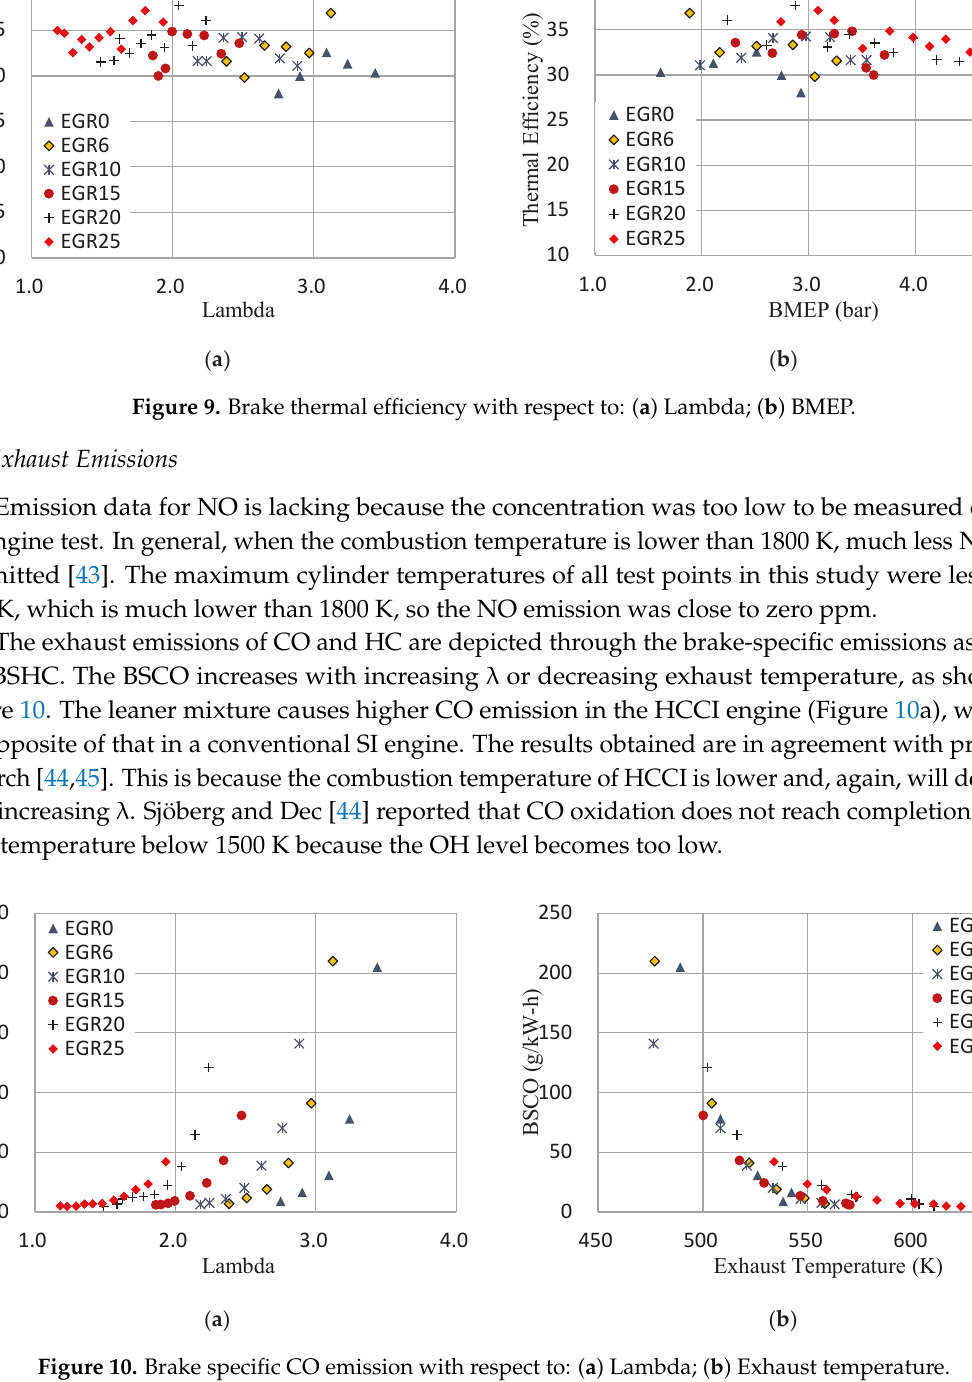
Figure 9. Brake thermal efficiency with respect to: ( a ) Lambda; ( b ) BMEP.